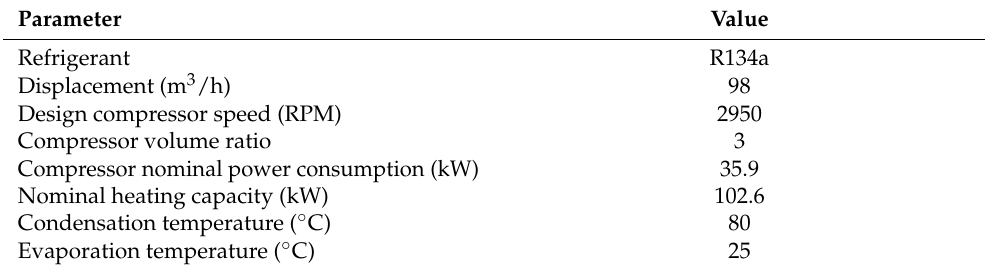
Table 3. Design specifications of the heat